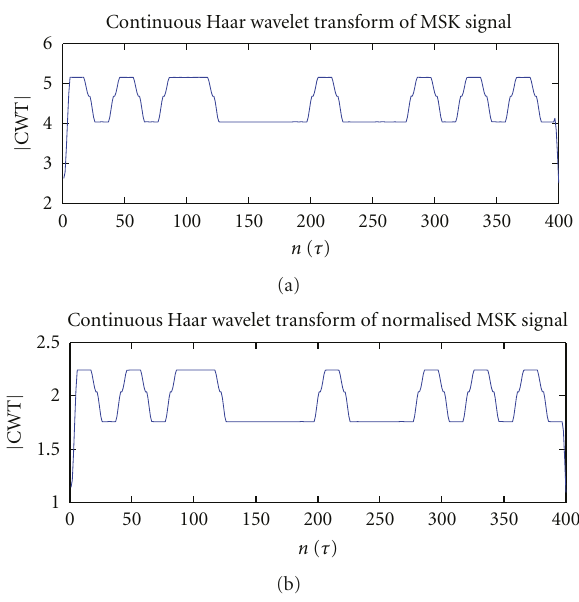
Figure 5: Multi-step wavelet transform of MSK signal and its normalized